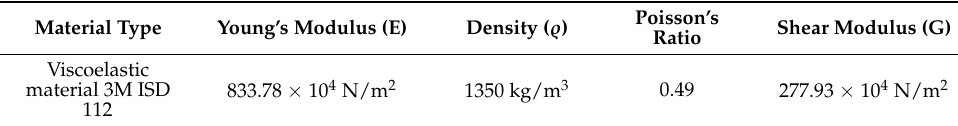
Table 4. The viscoelastic layer’s material